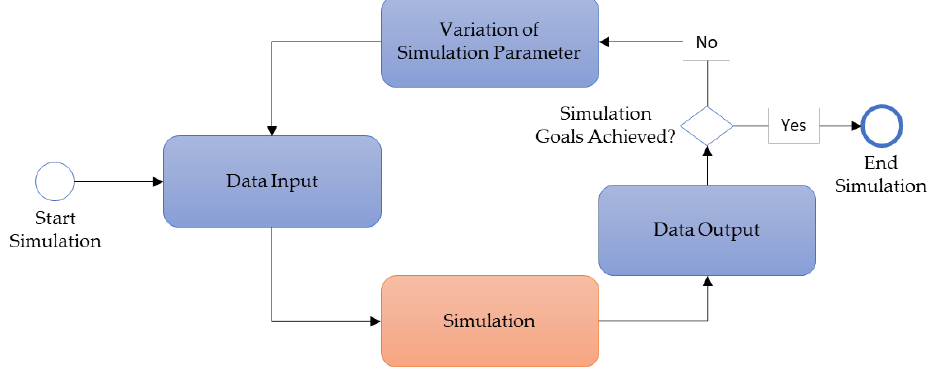
Figure 1. General procedure of a simulation study, according to